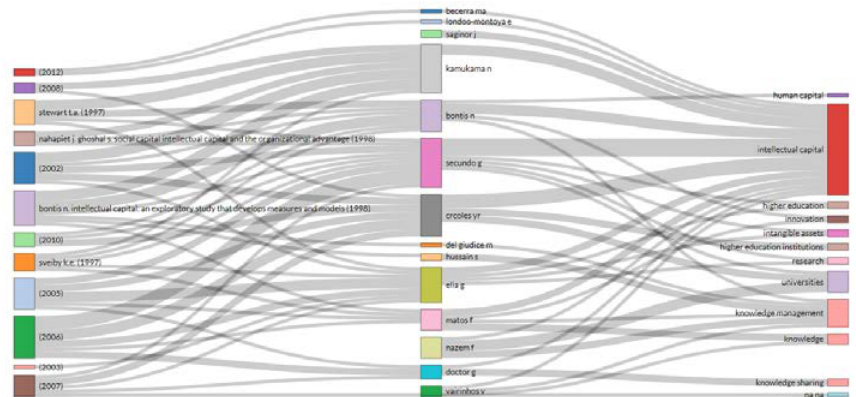
Figure 13. Three-Fields plot for the reference–authors–keywords.